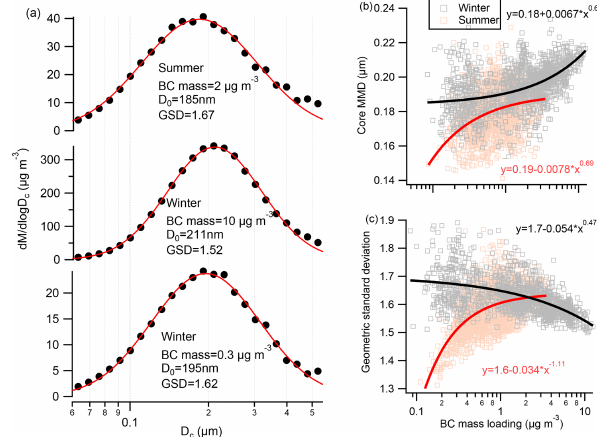
Figure 7. (a) BC core size distribution averaged over different rBC mass loading conditions in both seasons, showing the log-normal fitting and the fitted peak diameter ( D 0 ) and geometric standard de- viation (GSD); (b) BC core MMD as a function of BC mass loading and parameterization; (c) BC core GSD (from the fitting) as a func- tion of BC mass loading and their fitting functions. The line and error bars show the mean ± σ at each rBC mass